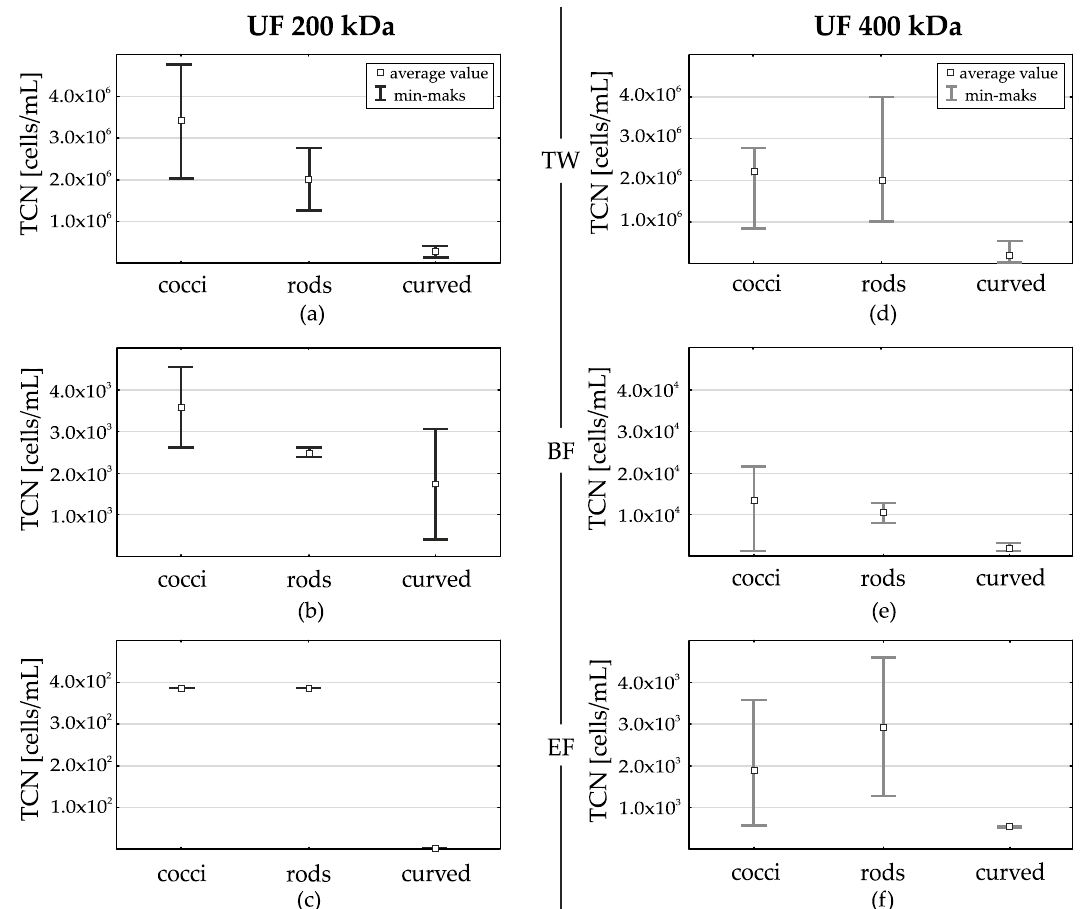
Figure 6. Comparison of the cells number of differently shaped (cocci, rods and curved), in treated wastewater (TW) and subjected filtration using membranes UF 200 kDa and UF 400 kDa [( a ) and ( d ), respectively], at the beginning of the filtration cycle (BF) [( b ) and ( e ) respectively] and at the end of the filtration cycle (EF) [( c ) and ( f ) respectively].